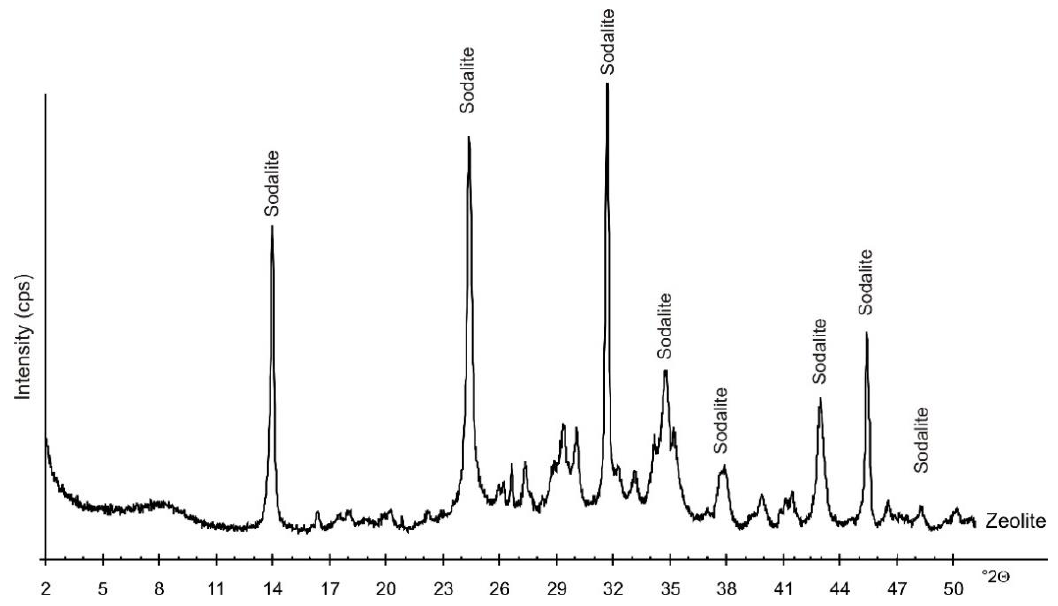
Figure 2. XRD pattern of zeolite material formed from fly ash.